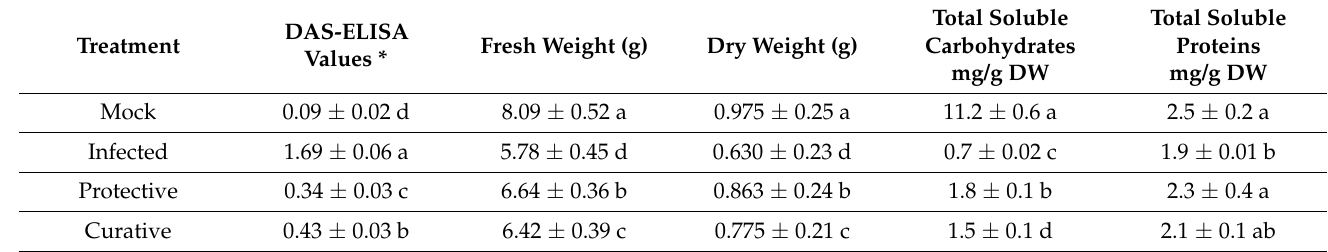
Figure 3. Morphological characteristics of squash leaves under ZYMV challenge in different treat- ments at 16 days post-ZYMV inoculation. Mock: squash plants foliar sprayed with sterile nutrient broth and mocked with viral inoculation buffer; infected: squash plants mechanically inoculated with ZYMV with foliar spraying of sterile nutrient broth; protective: squash plants sprayed with Paenibacillus polymyxa strain SZYM-CF 24 h before ZYMV inoculation; curative: squash plants sprayed with SZYM-CF 24 h after ZYMV inoculation. Table 2. The DAS-ELISA values, growth parameters, and total soluble carbohydrates and proteins of squash plants under ZYMV challenge upon treatment with Paenibacillus polymyxa strain SZYM-CF. Mock: squash plants foliar sprayed with sterile nutrient broth and mocked with viral inoculation buffer; infected: squash plants mechanically inoculated with ZYMV with foliar spraying of sterile nutrient broth; protective: squash plants sprayed with P. polymyxa strain SZYM-CF 24 h before ZYMV inoculation; curative: squash plants sprayed with SZYM-CF 24 h after ZYMV